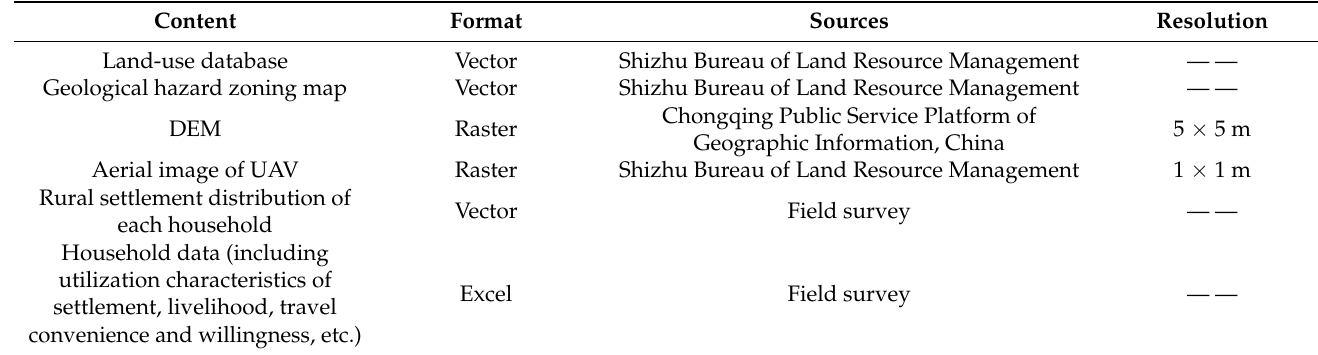
Table 1. Data sources of the study.